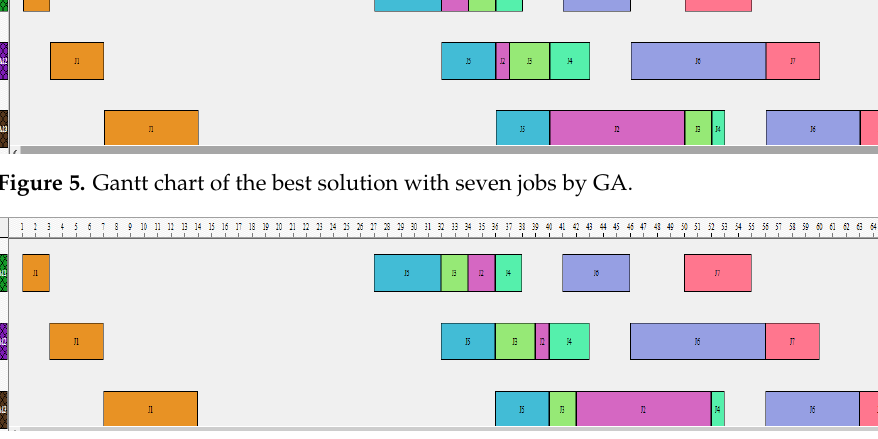
Figure 6. Gantt chart of the best solution with seven jobs by ACO.